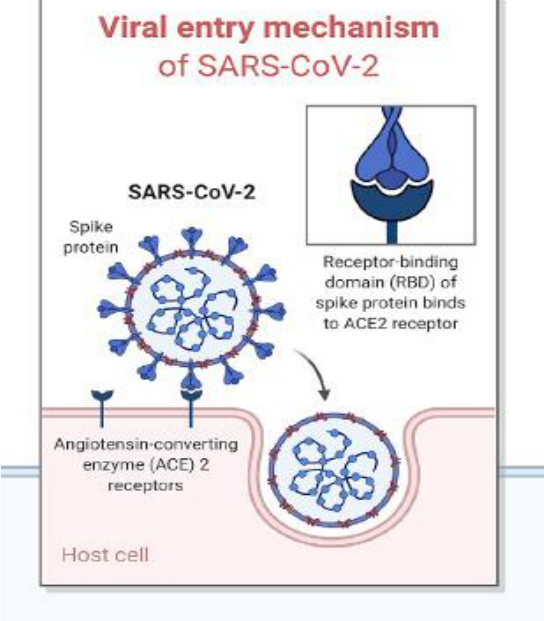
Figure 2. Role of ACE2 in the entry of COVID 19 into the host cells (51)